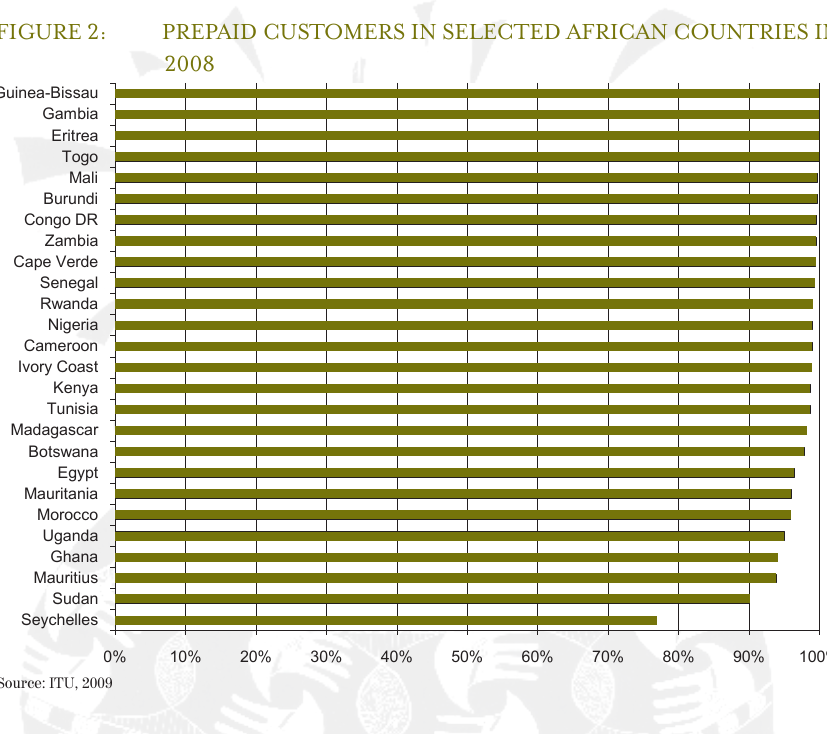
PREPAID CUSTOMERS IN SELECTED AFRICAN COUNTRIES IN